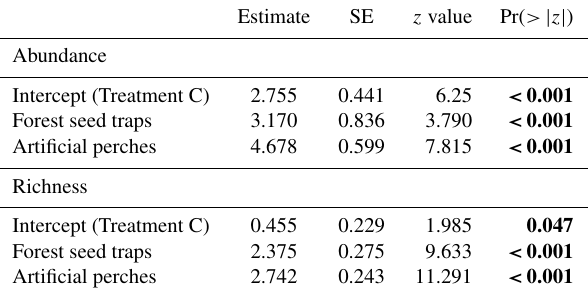
Table 1. GLMM output from effects of treatments on abundance and richness of seeds sampled at the Cascata Experimental Station, southern Brazil. SE: standard error; Treatment C: control seed traps. The values are on the log-link scale. Values in bold indicate signifi- cant differences.